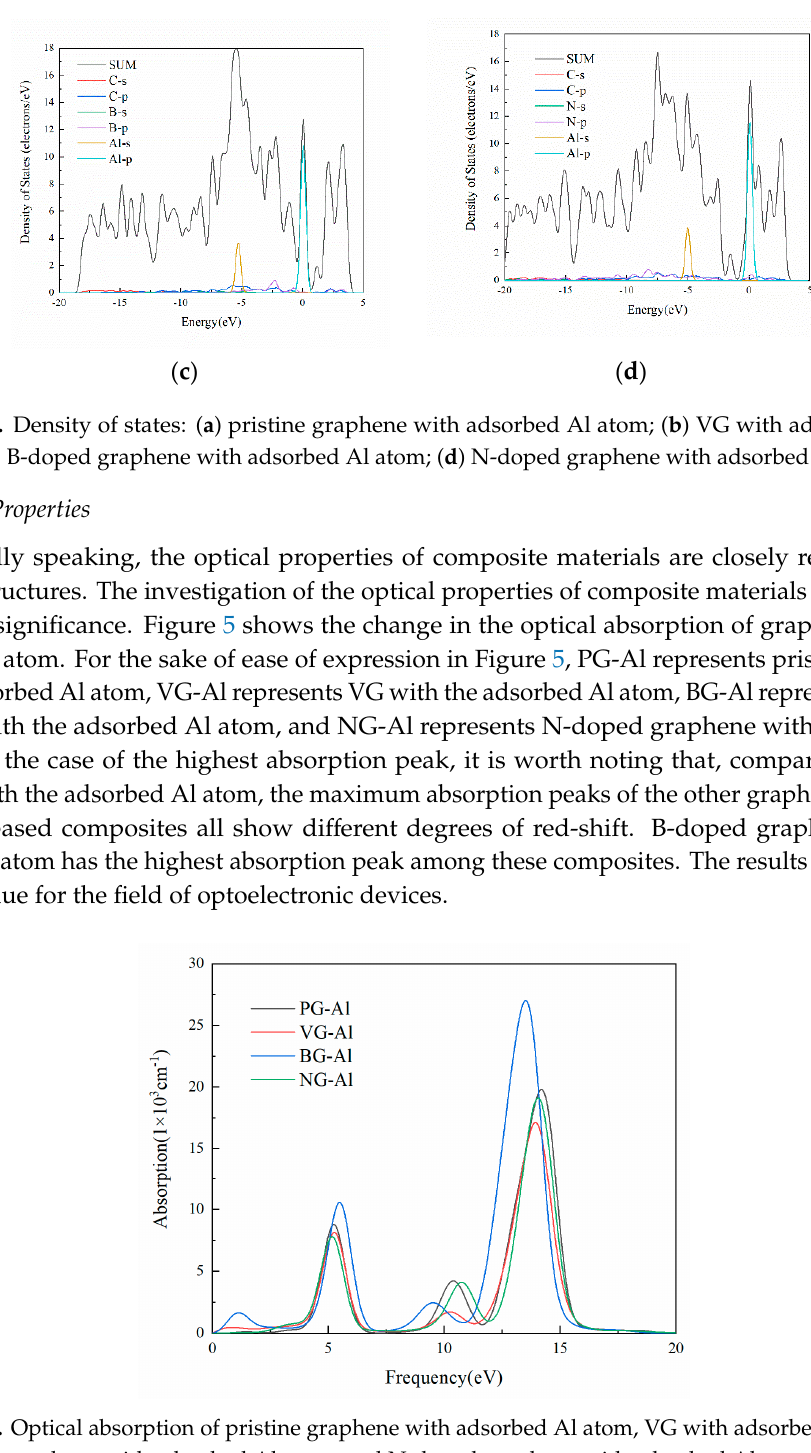
Figure 5. Optical absorption of pristine graphene with adsorbed Al atom, VG with adsorbed Al atom, B-doped graphene with adsorbed Al atom, and N-doped graphene with adsorbed Al atom.